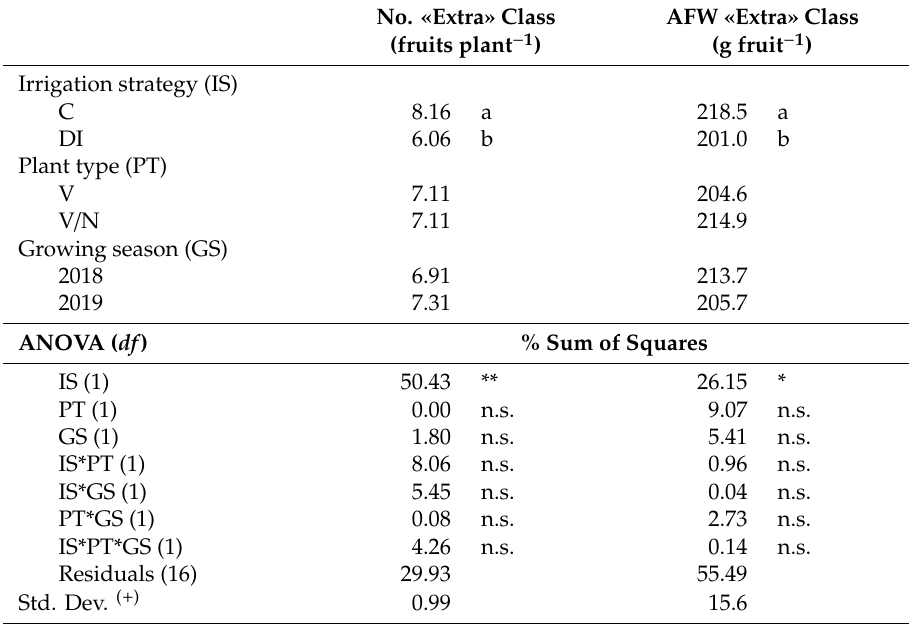
Table 5. E ff ect of irrigation strategy, plant type, and growing season on fruit number of «Extra» Class (No. «Extra» Class) and average fruit weight of «Extra» Class (AFW «Extra» Class). No. «Extra» Class AFW «Extra» Class (fruits plant − 1 ) (g fruit − 1 ) Irrigation strategy